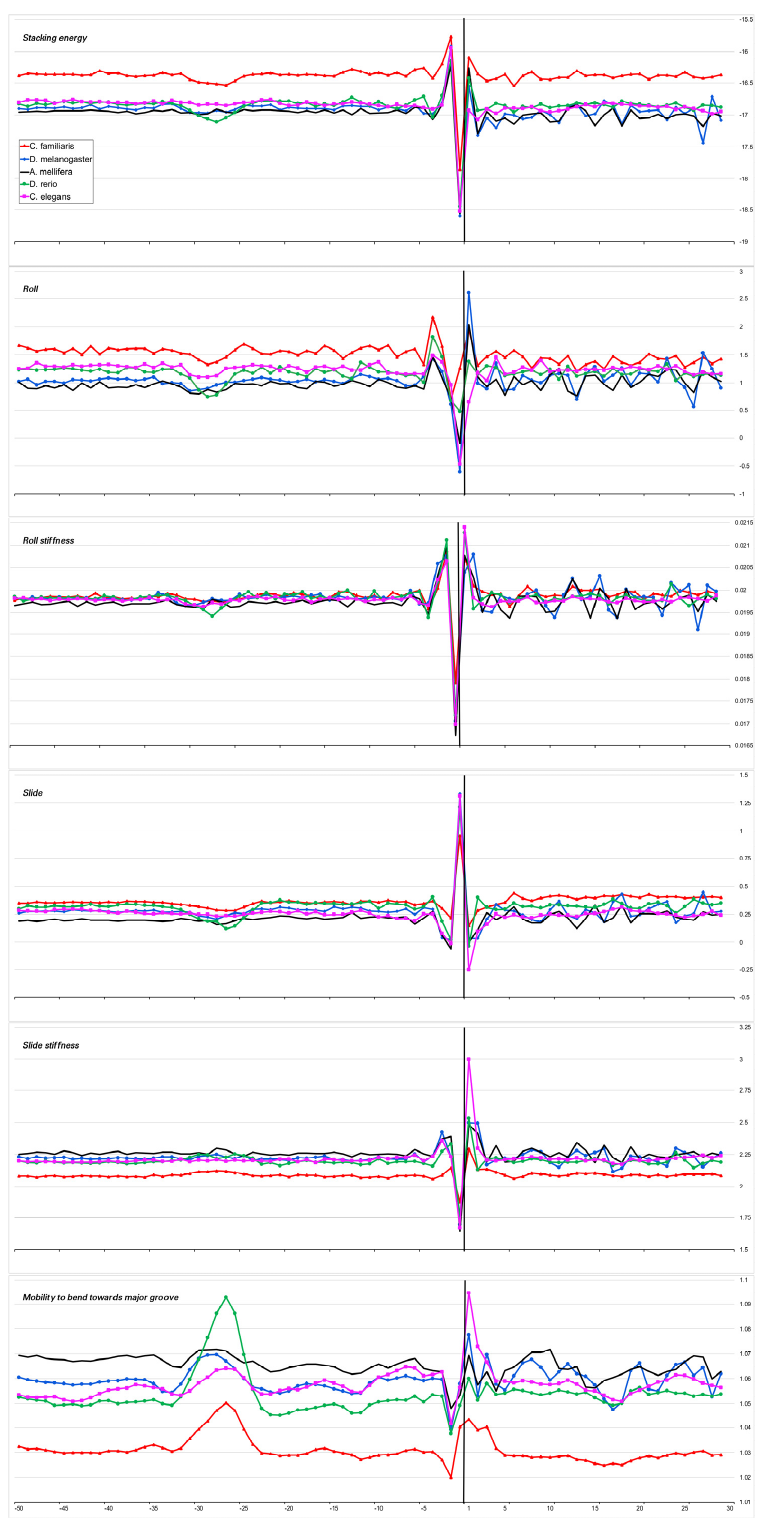
Figure 4. Local variations of the values of physical and structural parameters in core promoter regions of C. familiaris , D. melanogaster , A. mellifera , D. rerio , C. elegans . ( a ) Stacking energy (in kcal/mol). ( b ) Roll (in degrees). ( c ) Stiffness of the duplex structure to Roll alteration (in kcal/mol degree). ( d ) Slide (in angstroms). ( e ) Stiffness of the duplex structure to Slide alteration (in kcal/mol angstrom). ( f ) Mobility to bend towards major groove (in mobility